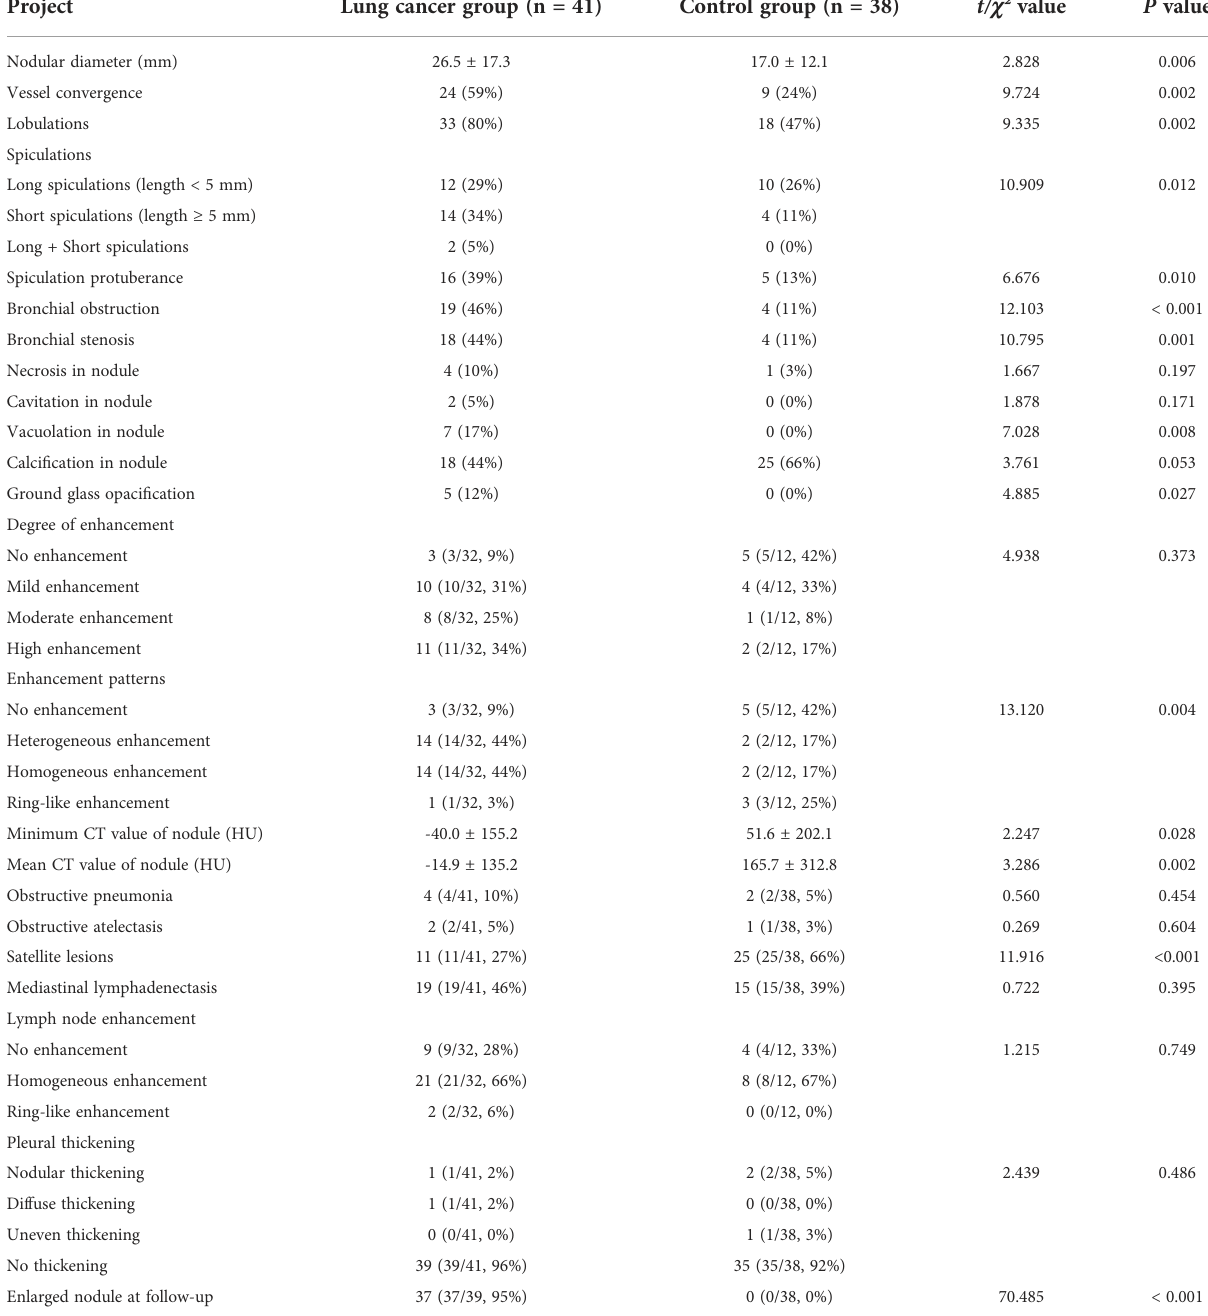
TABLE 2 CT features of patients with lung cancer occurrence in a lobe affected by tuberculosis and control